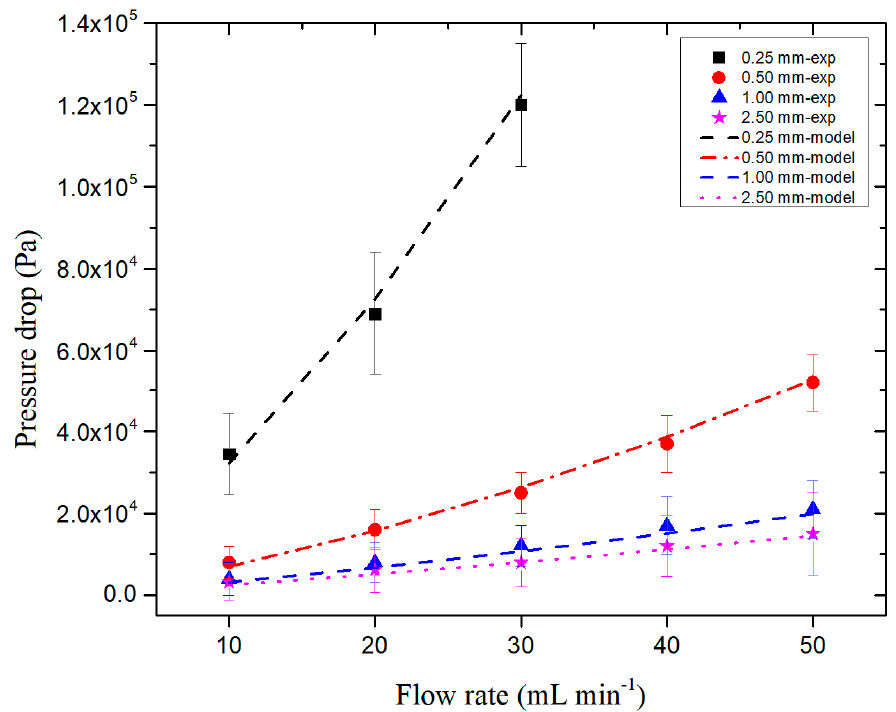
Figure 2. Computationally predicted and experimentally measured pressure drops through the strip cell, including inlet and outlet manifold pipes. Error bars reflect both pulsing from the peristaltic pump and experimental variability.